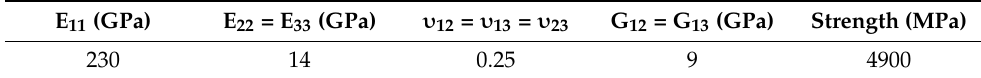
Figure 13. Finite element analysis of PWLC. Table 2. Mechanical parameters of carbon fiber.